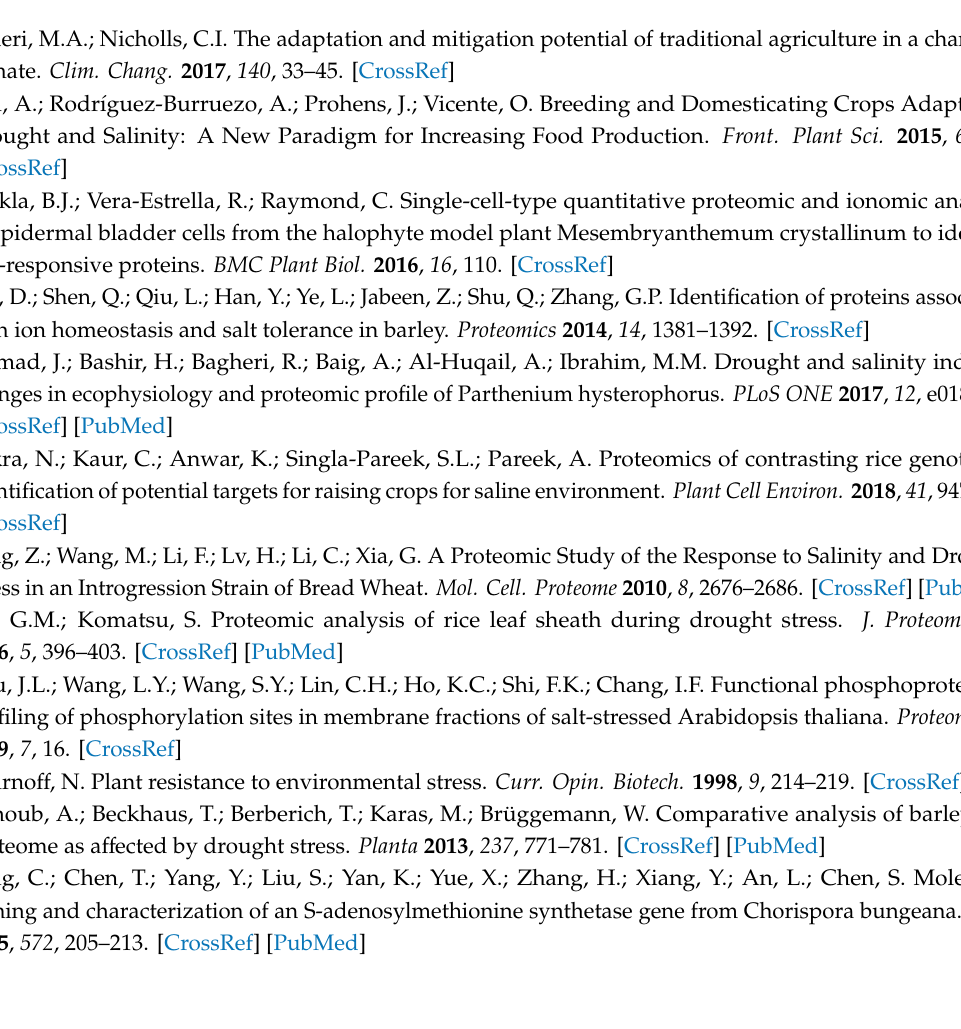
extracted from barley leaf. (B) Venn diagram analysis of leaf protein spots di ff erentially expressed among the three genotypes (XZ5 shown as yellow, XZ16 shown as cyan, and cv. CM72 shown as pink). Figure S3. ‘Spot view’ of the abundance of di ff erentially expressed proteins (indicated with green circles) in leaves of three barley genotypes XZ5, XZ16 and CM72 under control, (A) drought stress (SMC 4%) and (B) salinity stress (200 mM NaCl). Figure S4. (A) Functional category distribution of the 60 identified di ff erentially expressed proteins in this study. (B) Gene expression analyzed by qPCR. (C) The nucleotide and amino acid sequences of HvSAMS3 . Figure S5. Multiple alignment of amino acid sequences of AtSAMS1-AtSAMS4 and newly identified SAM in Barley ( HvSAMS1-HvSAMS4 ) and representative monocot species. The conserved S-adenosylmethionine synthetase N-terminal domain and S-adenosylmethionine synthetase central domain are shown. Figure S6. Silencing of the phytoene desaturase (PDS) gene, (A) leaf phenotype and (B) relative expression in wild barley XZ5 using BSMV-VIGS. (C)Relative expression of HvSAMS1, HvSAMS2 and HvSAMS4 was measured by using real-time PCR. Error bars represent SD values ( n =